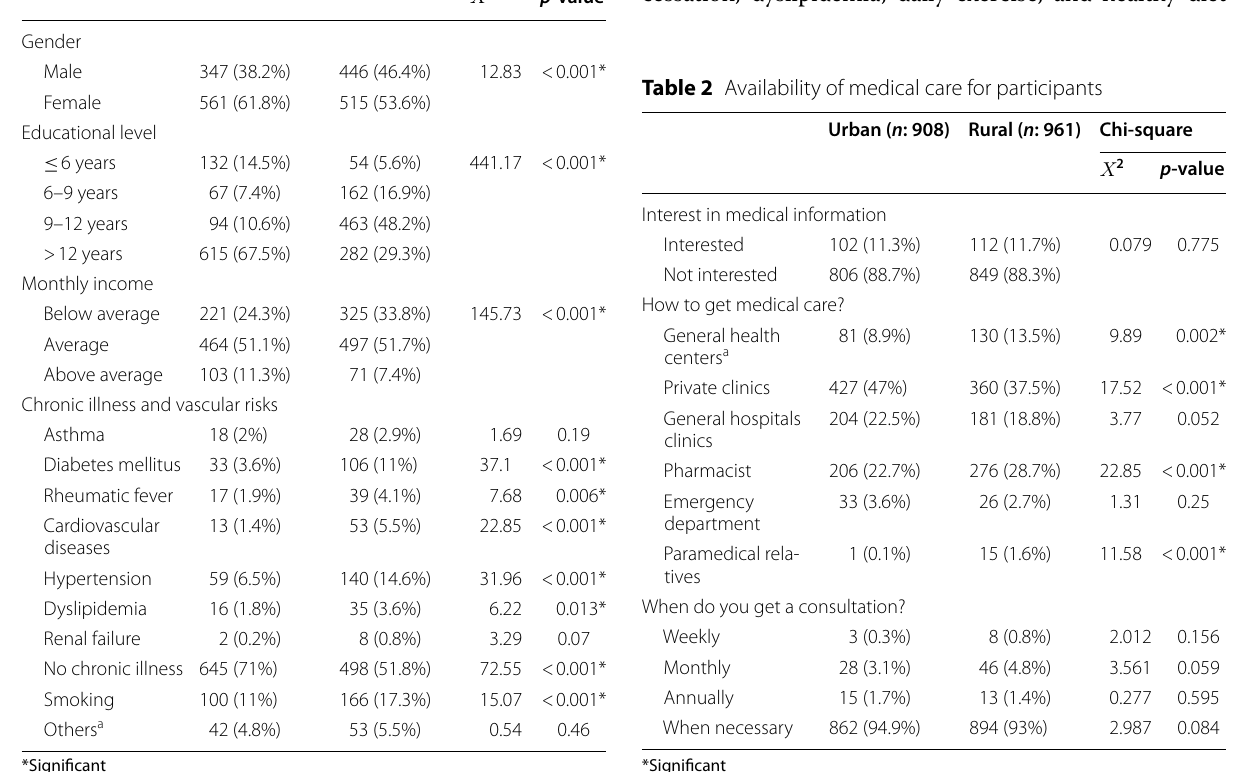
*Significant a General Health Centers or rural medical units under the management of the Egyptian ministry of health